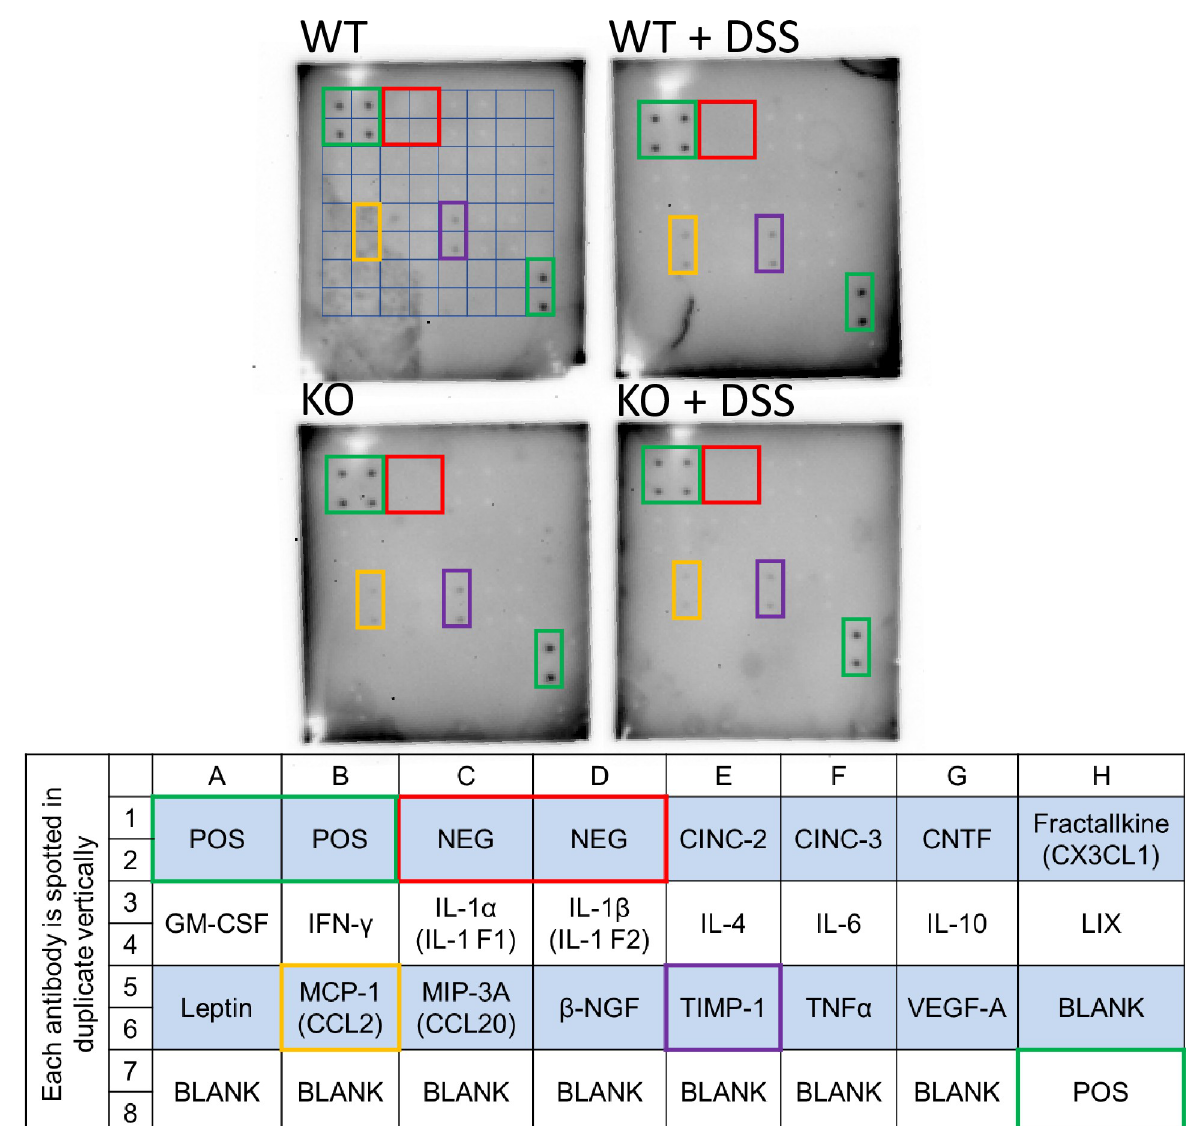
Fig 14. DSS treatment did not cause systemic inflammation in male rats of either genotype. Serum cytokines were assayed using a rat cytokine antibody array (AAR-CYT-1; RayBiotech, Norcross, GA). A grid was drawn on one blot for orientation, and positive (green) and negative (red) controls are indicated with boxes. The positive and negative controls worked as expected, validating the assay. The layout of the blots is shown in the table below (as provided by the manufacturer). Only two cytokines were positive MCP-1 (yellow boxes) and TIMP-1 (purple boxes), but levels were not noticeably different between genotypes or treatment